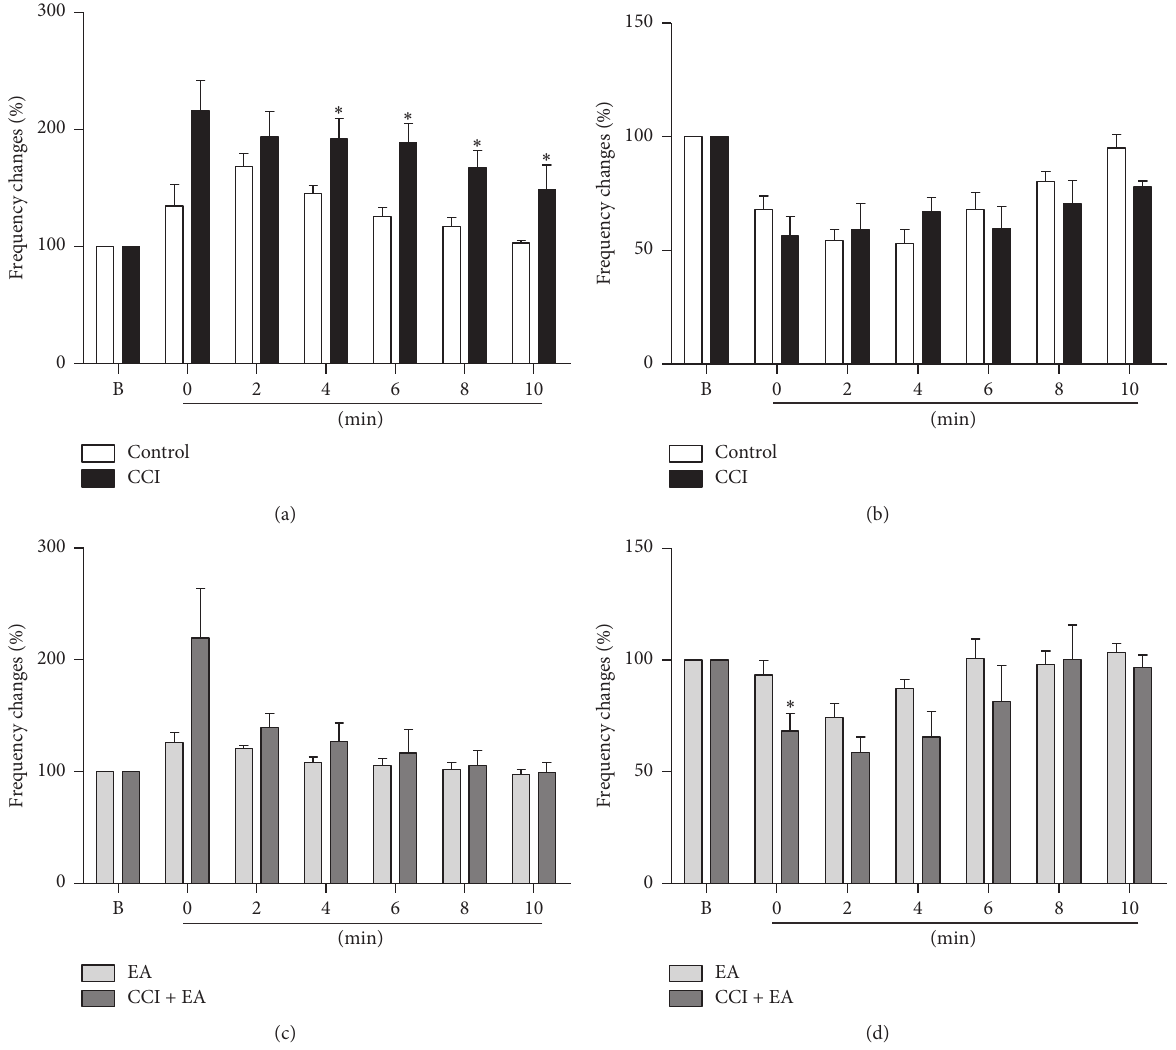
Figure 3: The differences in effects of acute noxious stimulation on the firing rate between sham and CCI rats. The brief sciatic nerve stimulation had a greater excitatory effect on the firing rate of PENs in CCI compared to sham rats (a) and a similar effect on PINs in both CCI and sham rats (b). Also, EA blocked the excitatory effect of the acute noxious stimulus on the firing rate of PENs in both sham and CCI rats (c) and produced slightly less blocking of the inhibitory effect of noxious stimulation on PINs in CCI rats compared to sham rats (d). ∗ : compared with the control group, 𝑃 < 0.05